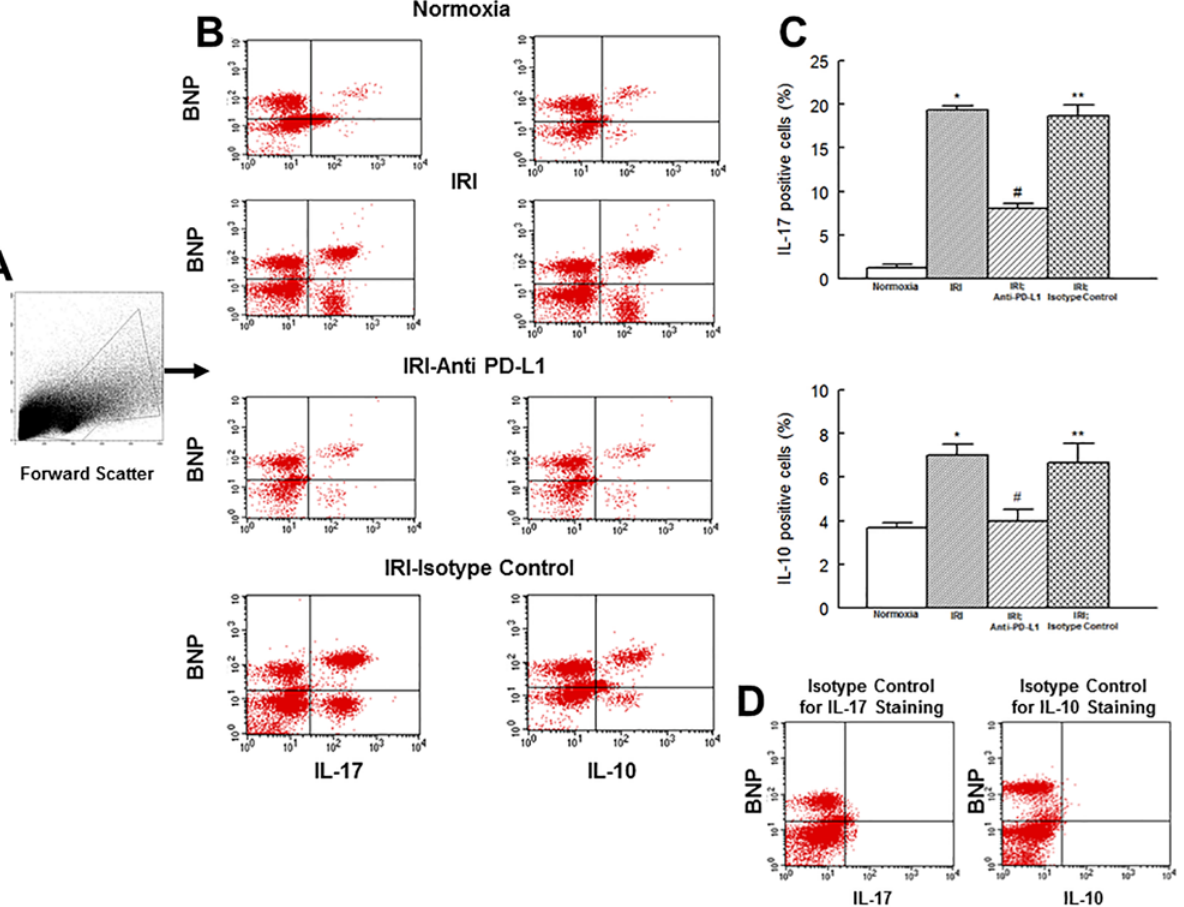
Fig 4. Flow cytometry profile of cardiac cell preparations outlining gated events is shown under panel A. Under panel B, representative scatter plots for interleukin (IL)-17 and IL-10 positive cells in heart cell preparations are shown for experimental groups. Bar graphs show percent of cells which were positive for either IL-17 or IL-10 (panel C); data are means ± SEM; n = 6 hearts/group for normoxic control, IRI and IRI; Anti-PD-L1 and n = 4 for IRI; isotype matching control. Also shown under panel D are representative plots of staining isotype controls for IL-17 and IL-10 from FACS analysis for gating purpose. IRI: Ischemia Reperfusion Injury. * p < 0.05 compared to the normoxic group. ** p < 0.05 compared to normoxia or IRI; Anti-PD-L1 group. # p < 0.05 compared to IRI or IRI; isotype control group.